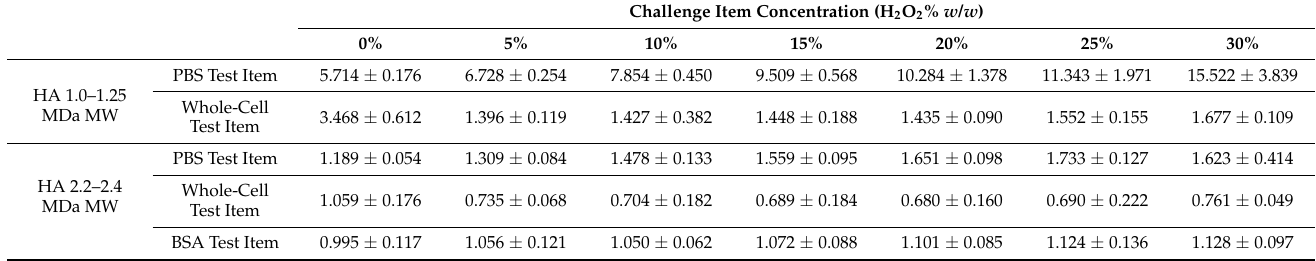
Table 2. Loss factor tan δ 1 values of lyophilized whole-cell samples resuspended in various HA- based hydrogels and challenged with various doses of H 2 O 2 for 1 h, corresponding to the complex viscosity η * values presented in Figure 5A–C. The mean values are presented for each group and assay condition along with the corresponding standard deviations. BSA, bovine serum albumin; HA, hyaluronic acid; MDa, megaDalton; MW, molecular weight; PBS, phosphate-buffered saline. Challenge Item Concentration (H 2 O 2 % w/w